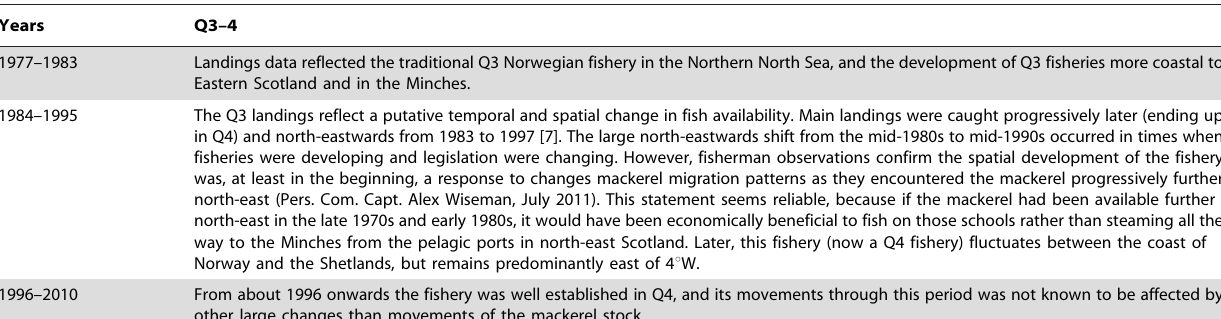
Table 1. Factors affecting spatiotemporal distribution of the commercial fishery in Q3–4.